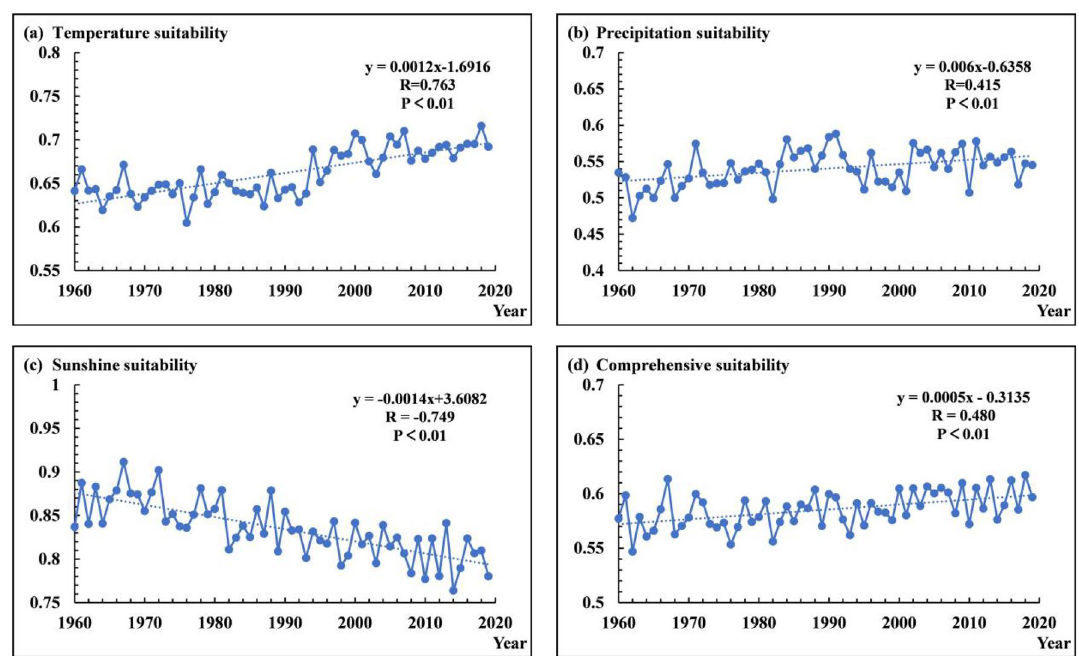
Figure 5. Change trend of peanut climatic suitability in Huang-Huai-Hai Region from 1960 to 2019: ( a ) Temperature suitability, ( b ) Precipitation suitability, ( c ) Sunshine suitability, ( d ) Comprehensive